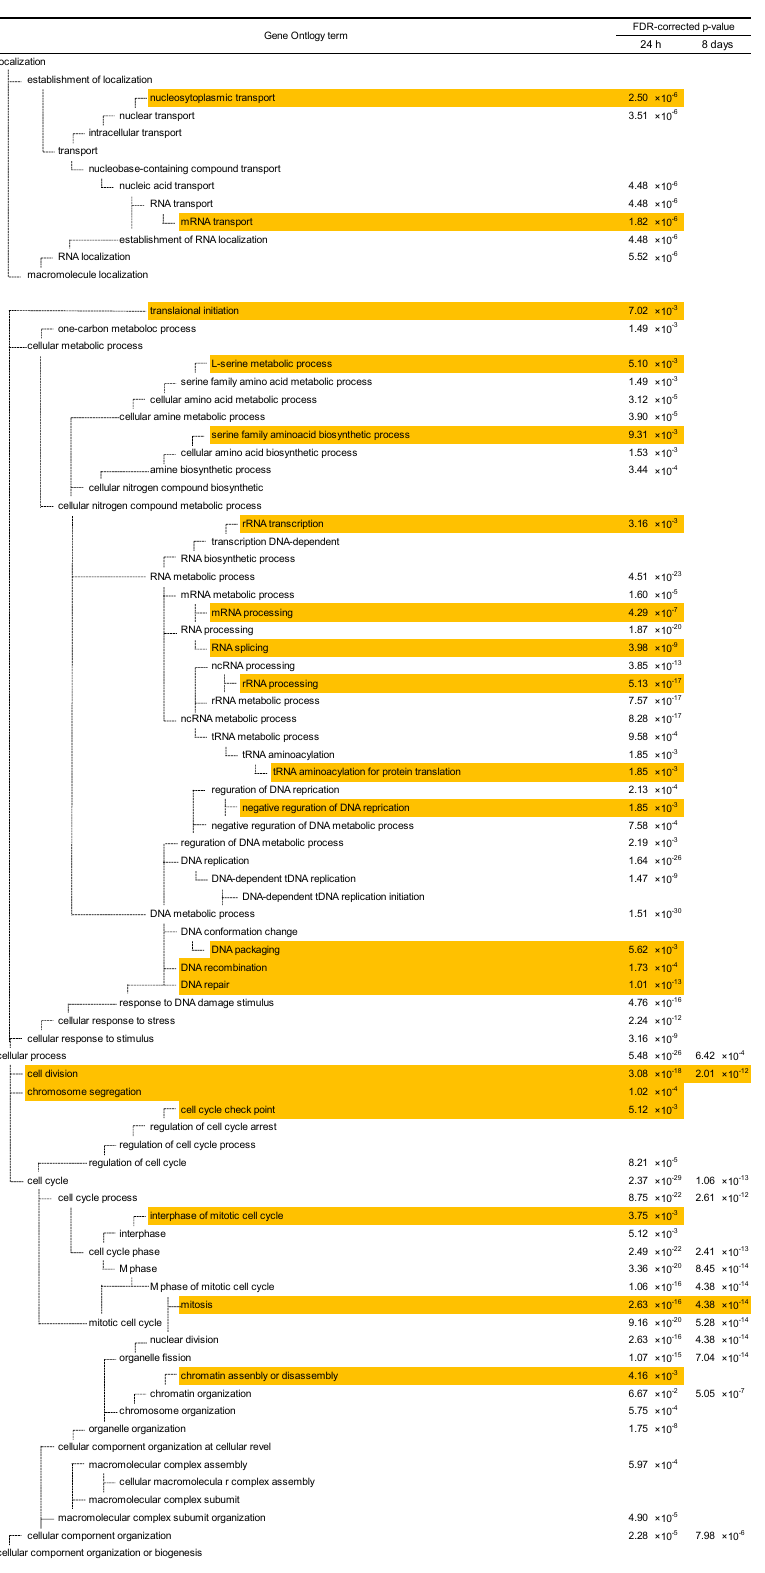
Figure 3. Gene Ontology terms for selected genes. The GO terms up-regulated due to TPA treatment for ( A ) 1 h and 6 h. Gene Ontology terms for selected genes (continued). The GO terms up-regulated due to TPA treatment for ( B ) 24 h and 8